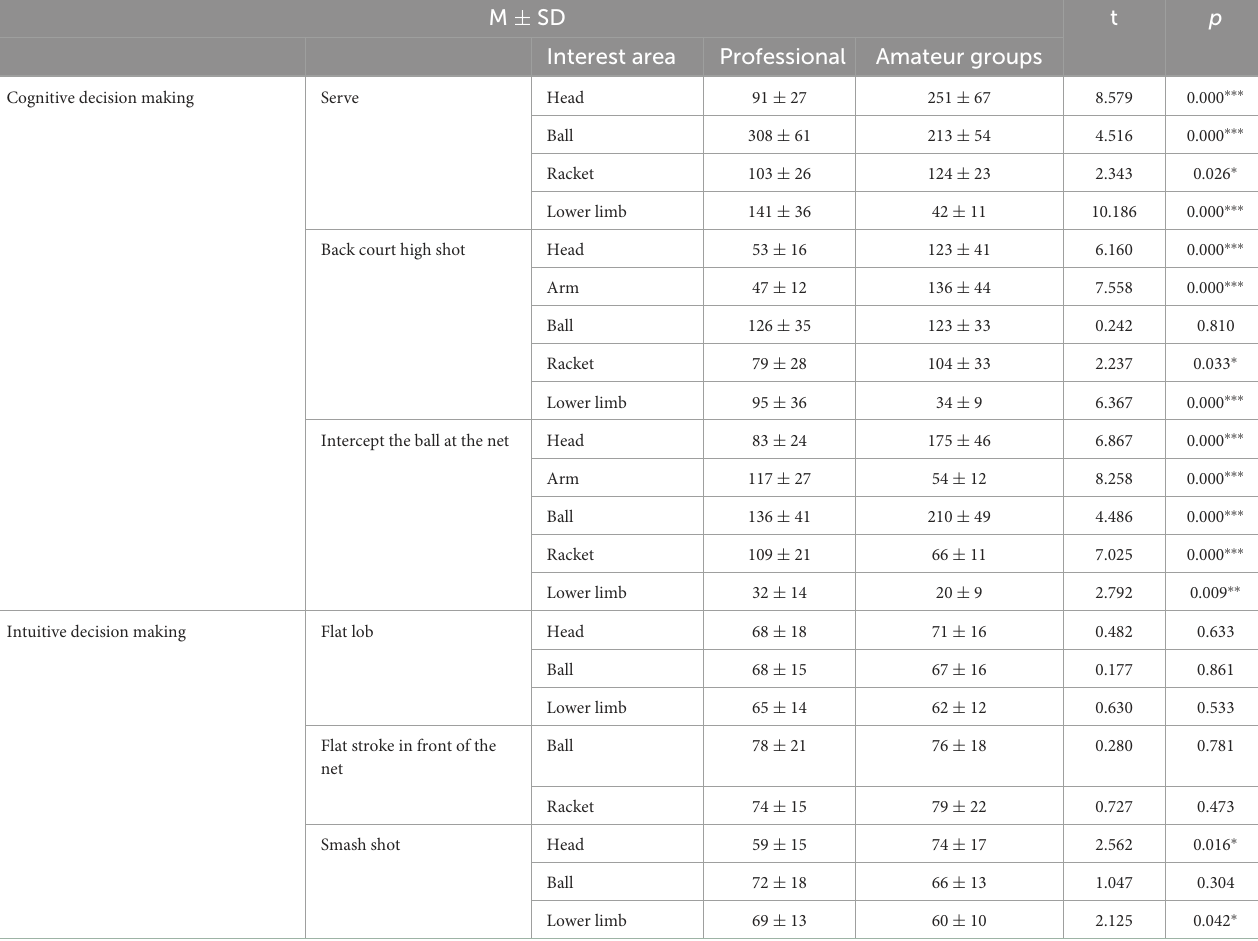
TABLE 8 A comparison of the fixation time in the different areas of interest between the two groups (unit: